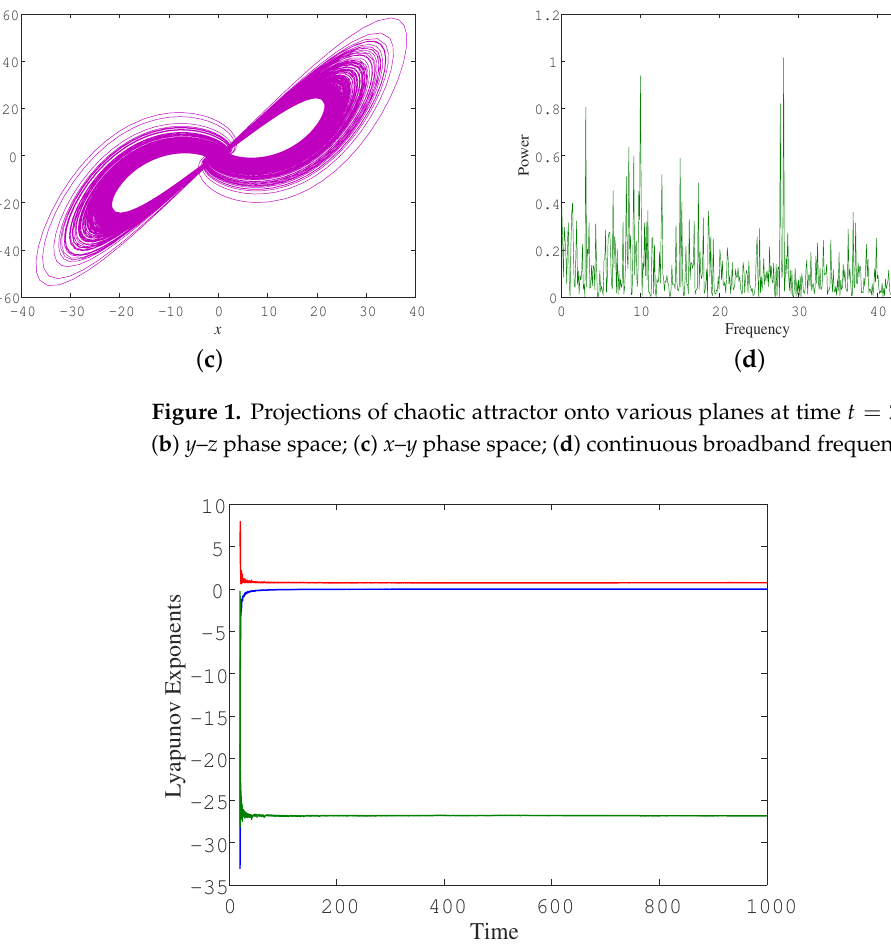
Figure 2. Lyapunov exponent spectrum of system (1) for ( a , b , c , k ) = ( 10,100,11.2, − 0.2 )